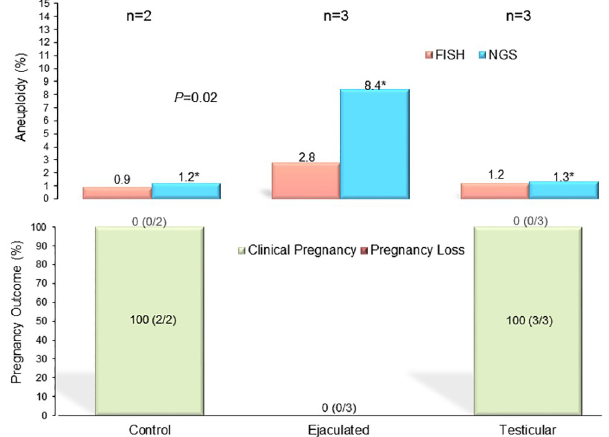
Fig 4. Sperm aneuploidy assessed by FISH and NGS of ejaculated and testicular specimens from the same individuals with related pregnancy outcome. The two-sample t -test and Mann-Whitney U test were used to compare the autosomal and gonosomal aneuploidy rates assessed concurrently by FISH and NGS, in the same individuals, on at least 1000 spermatozoa. A higher incidence of aneuploidy was found in the ejaculated (n = 3) in comparison to the testicular (n = 3) and donor control specimens (n = 2) ( P = 0.02) (Upper graph). In the lower graph, the Friedman’s Chi-square used to compare the clinical pregnancy according to the source of spermatozoa used for ICSI did not evidence any statistical